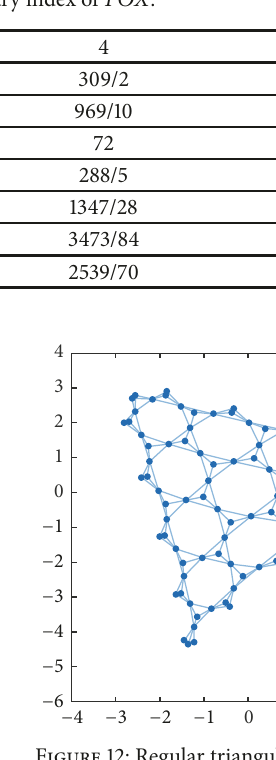
Figure 10: Regular triangular silicate network (unit cell).